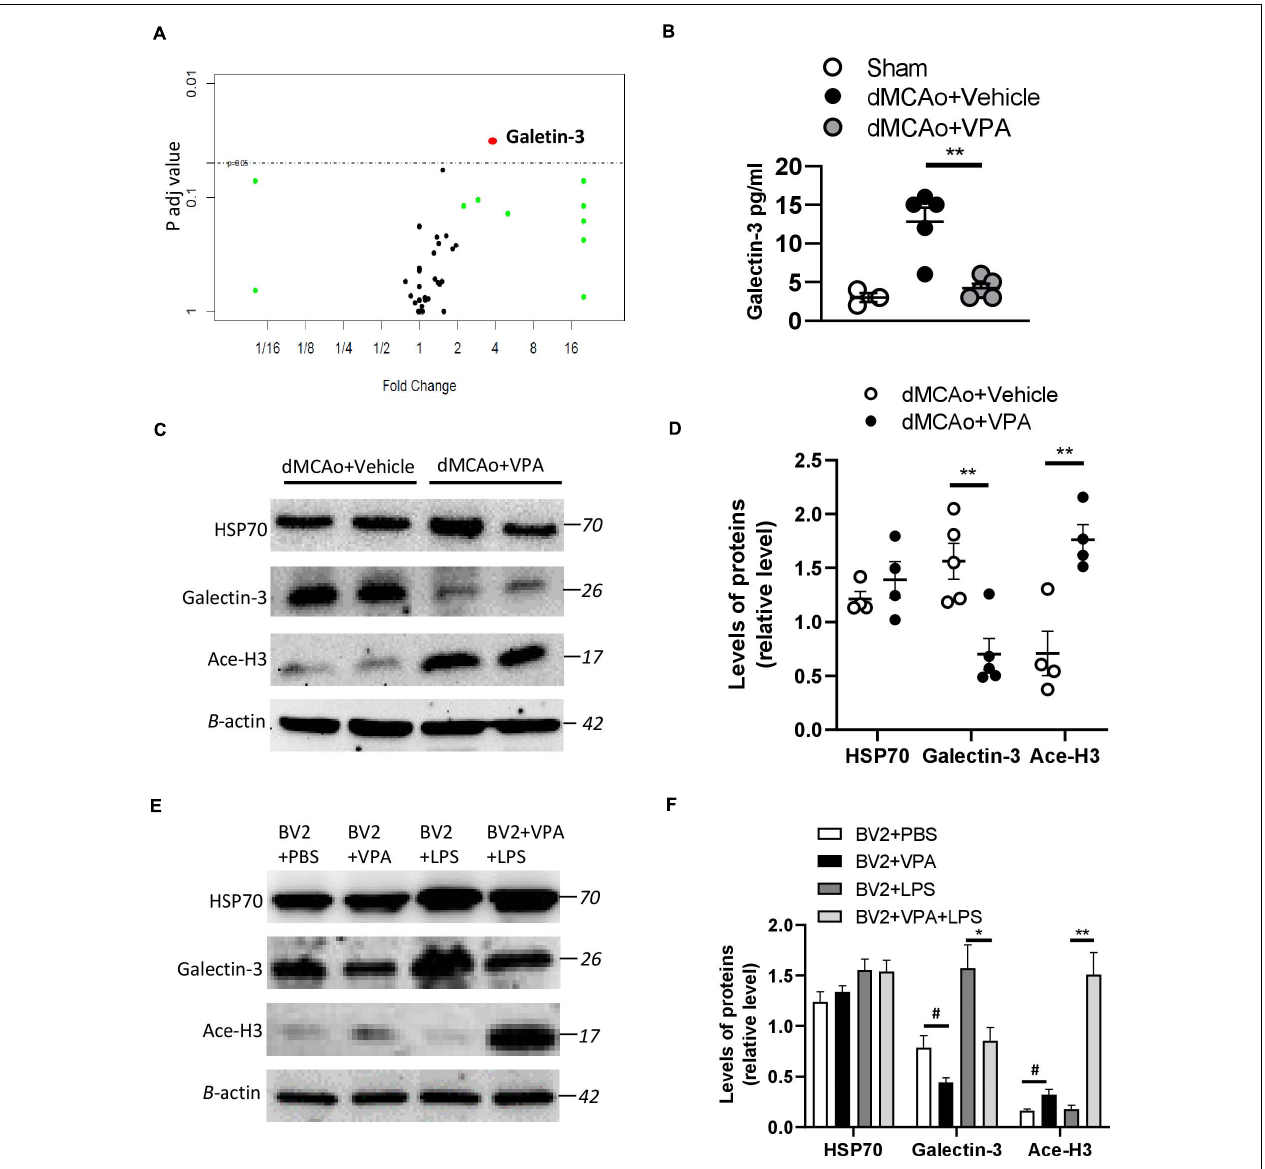
FIGURE 6 | Effects of VPA treatment on galectin-3 expression in the peri-infarct cortex and BV2 cells. (A) Volcano plot comparing the fold changes and adjusted p-values of 67 biomarkers in which each point represents a biomarker. (B) VPA suppresses galectin-3 production in the peri-infarct cortex of rats with ischemic brain injury. Galectin-3 concentrations in the peri-infarct cortex at 2 days after dMCAo surgery were measured by ELISA ( n = 5). ** p < 0.01, compared with the vehicle-treated group. (C) Protein levels of HSP70, acetylated H3 (Ace-H3), galectin-3, and β -actin were determined by western blot analysis. (D) Quantified results of HSP70, Ace-H3, and galectin-3. Each column and vertical bar represents the mean ± SEM of 5 animals. ** P < 0.01, Student’s t -test. (E) BV2 cells were activated using LPS (1 µ g/ml) and, simultaneously, in the presence or absence of VPA as indicated. After 6 h of treatment, the protein levels of HSP70, acetylated H3 (Ace-H3), galectin-3, and β -actin were determined by western blot analysis. (F) VPA treatment enhances the levels of Ace-H3, but suppresses galectin-3 production in the BV2 cells with/without LPS exposure. # p < 0.05 vs. control. * p < 0.05 and ** p < 0.01 indicate comparison with LPS-treated BV2 cells with Student’s t -test. The data represent mean ±